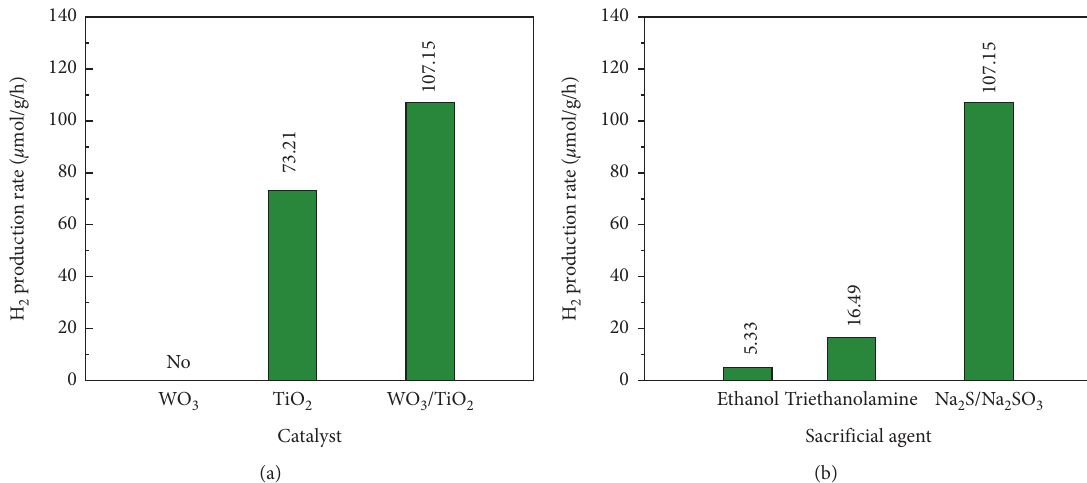
Figure 10: (a) H 2 production rate over WO 3 , TiO 2 , and 5% WO 3 /TiO 2 nanofibers. (b) H 2 production rate from different sacrificial agents over 5% WO 3 /TiO 2